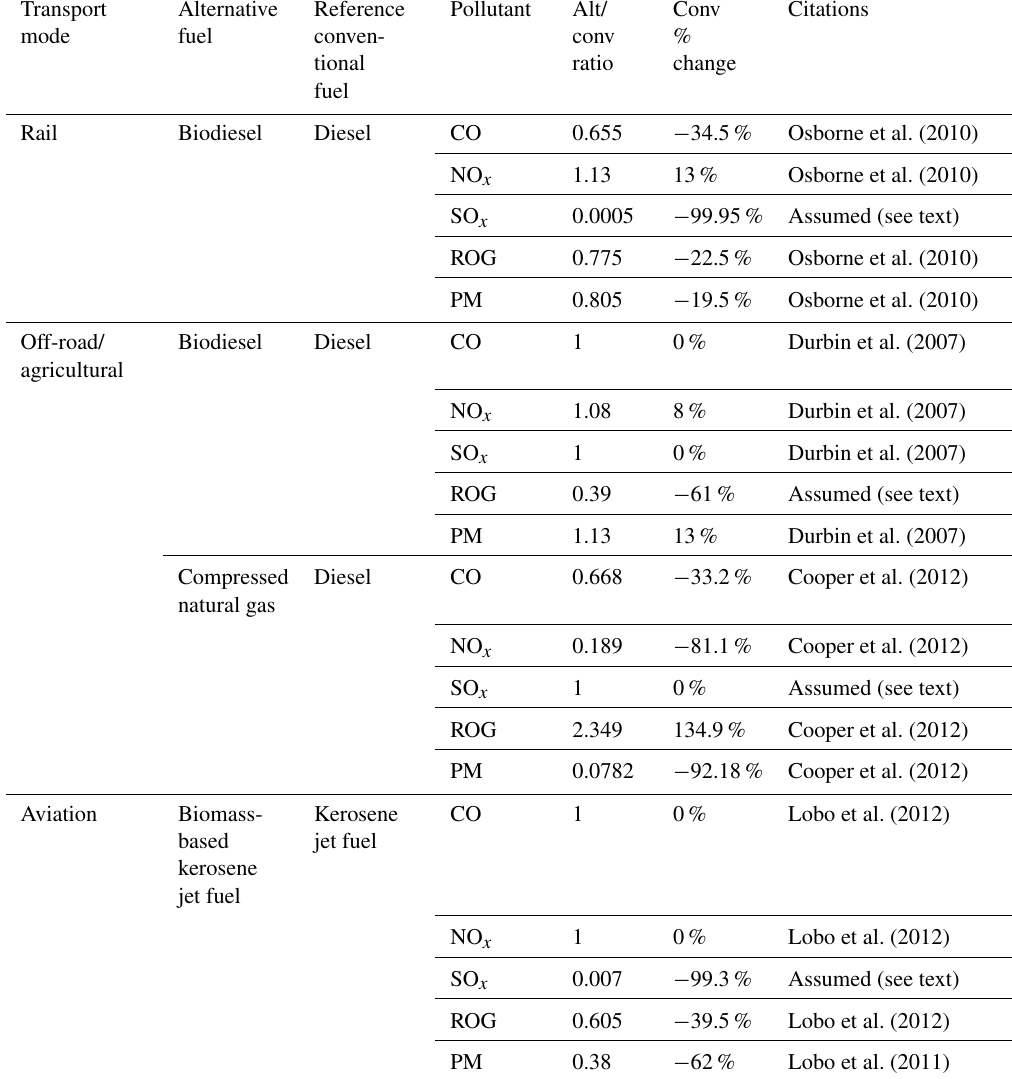
Table 2. Emissions rate changes for alternative fuels in off-road